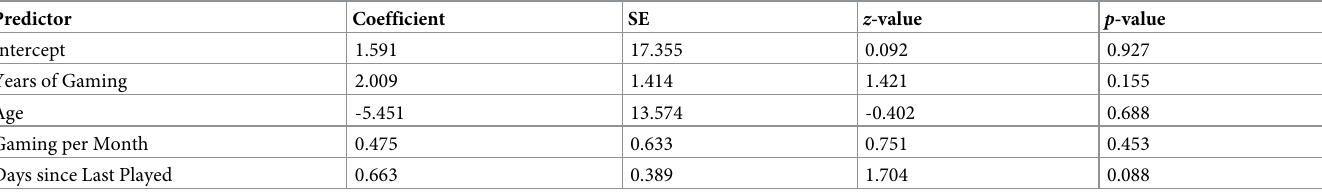
Table 2. Experiment 1: Mixed logit analysis of participant gaming responses predicted by gaming experience.